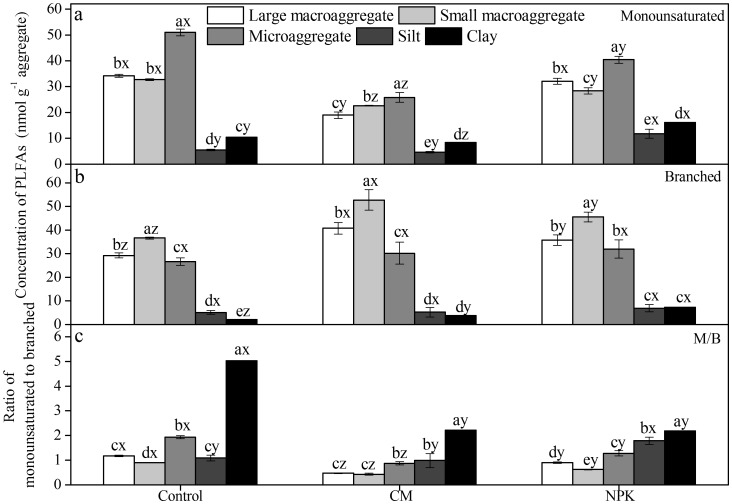
Effect of long–term applications of fertilizer NPK and compost on concentrations (nmol g–1 aggregate) of monounsaturated and branched PLFA in aggregates.Values are means (n = 4) with standard error. Different letters denote significant differences between aggregates with the same treatment (a, b, c, d, e) and between treatments with the same aggregate (x, y, z) at P<0.05, respectively.